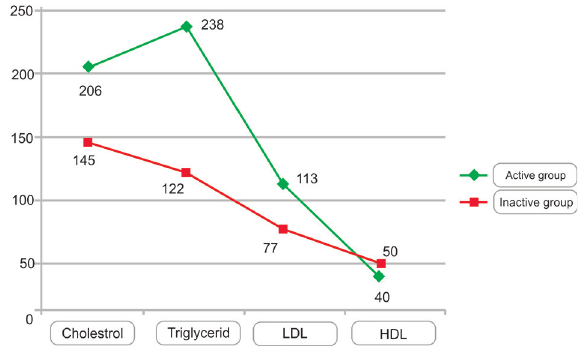
Figure 1. Frequency of lipid profile abnormalities in patients.